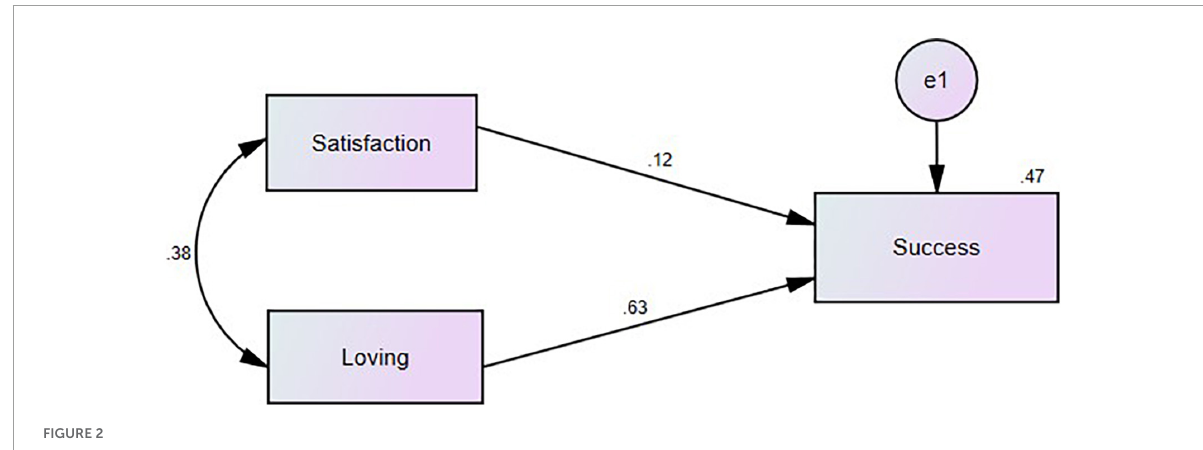
TABLE 5 Results of multiple linear regression analysis with SEM.